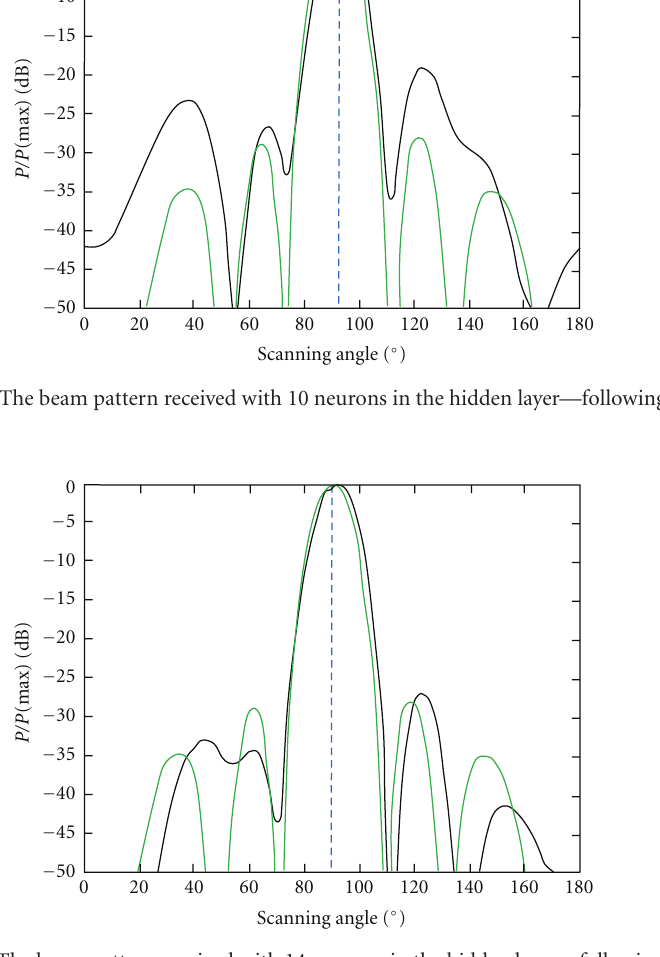
Figure 4: The beam pattern received with 14 neurons in the hidden layer—following ES.